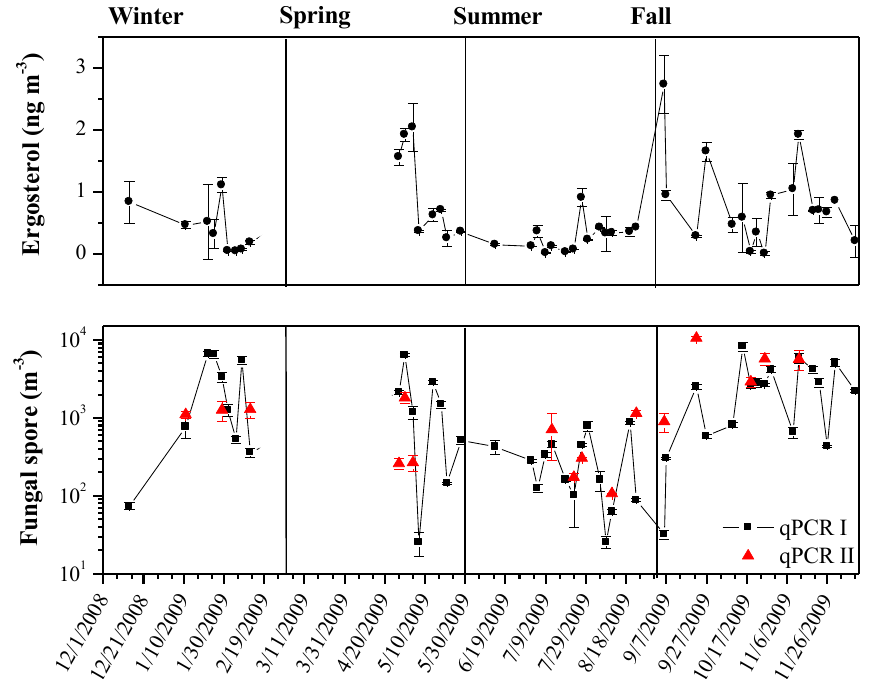
Fig. 2. Seasonal ergosterol concentrations (upper graph) (Burshtein et al., 2011), and fungal spore concentrations (bottom graph) from PM 10 filters. The qPCR I and qPCR II values refer to independent sample repeats. The error bars are standard deviations, n = 48 for ergosterol and qPCR I analysis of fungal spore, and n = 24 for qPCR II analysis of fungal